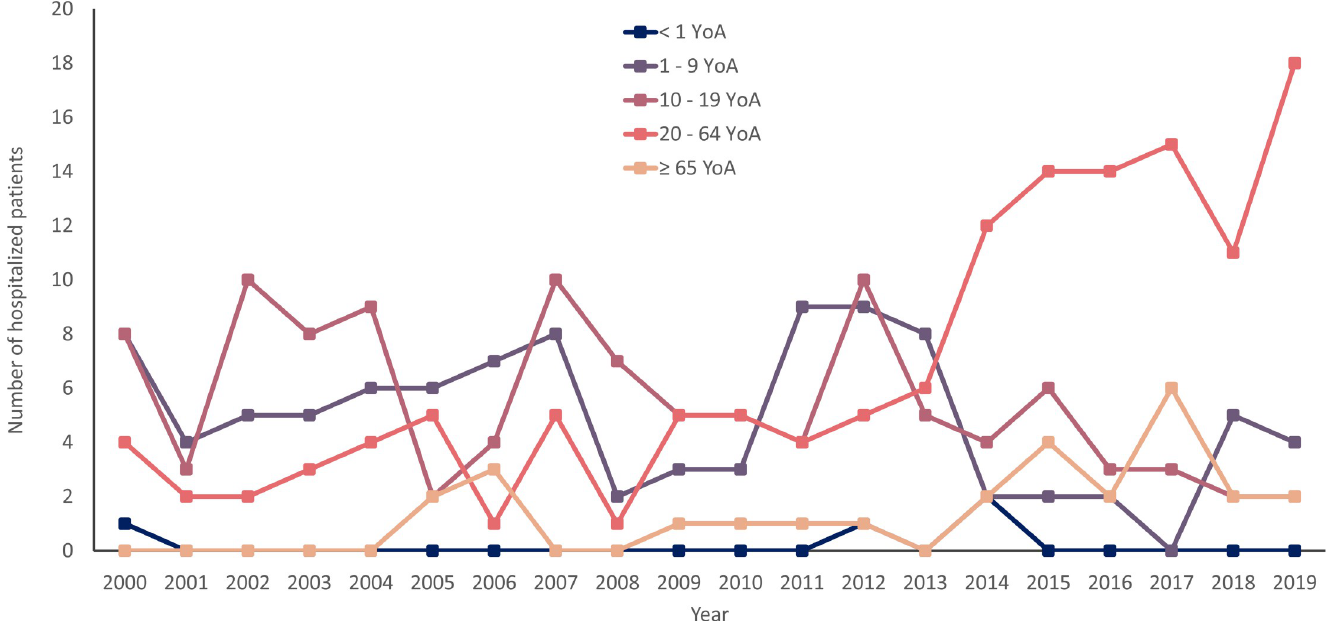
Fig 4. Hospitalizations due to HAV +FHF or ALF infection by age group and year in Mexico. YoA, years of age.